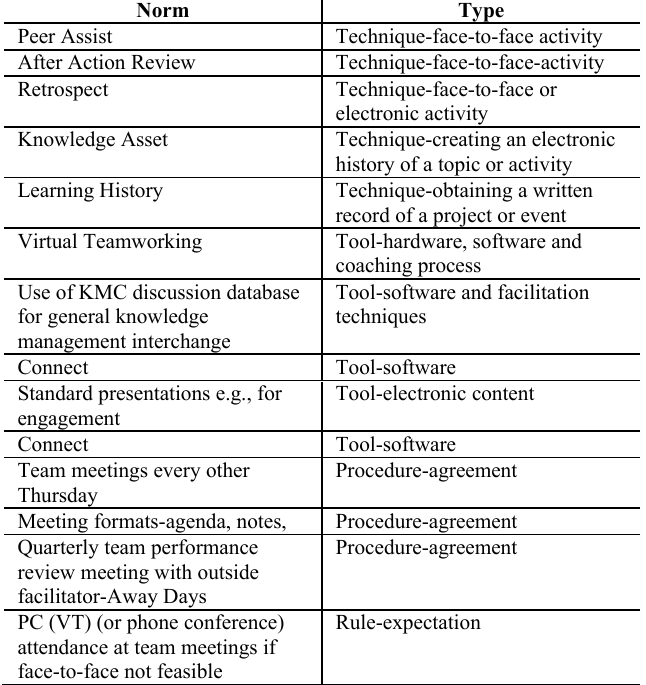
Table 1 : KMT norms identified during